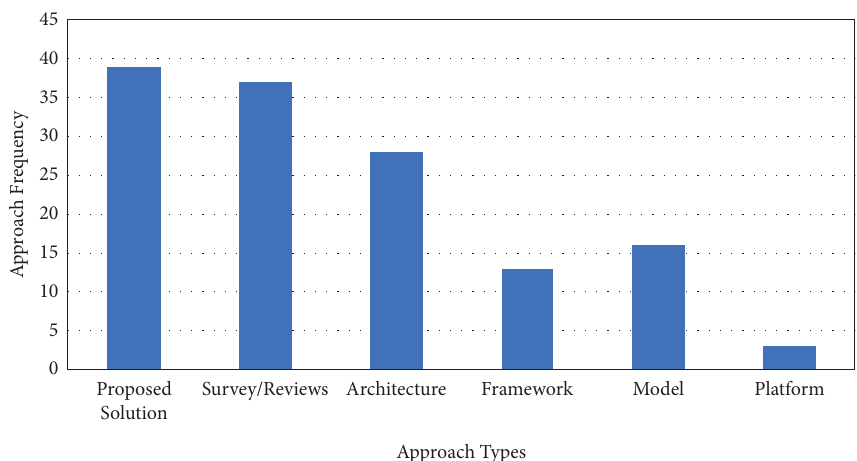
Figure 4: Research approaches in SAGIN based DMS. Table 6: RQ3: algorithm/approaches used for an effective SAGIN based